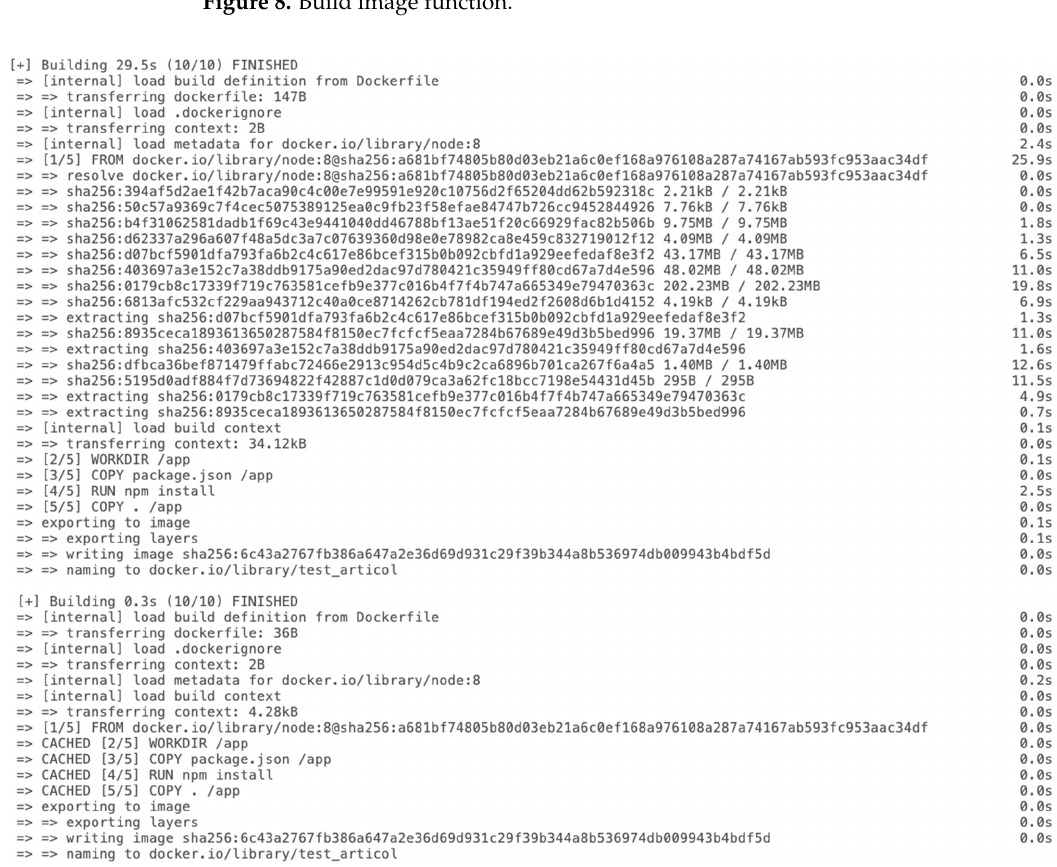
Figure 9. Docker-cached layers dataset.